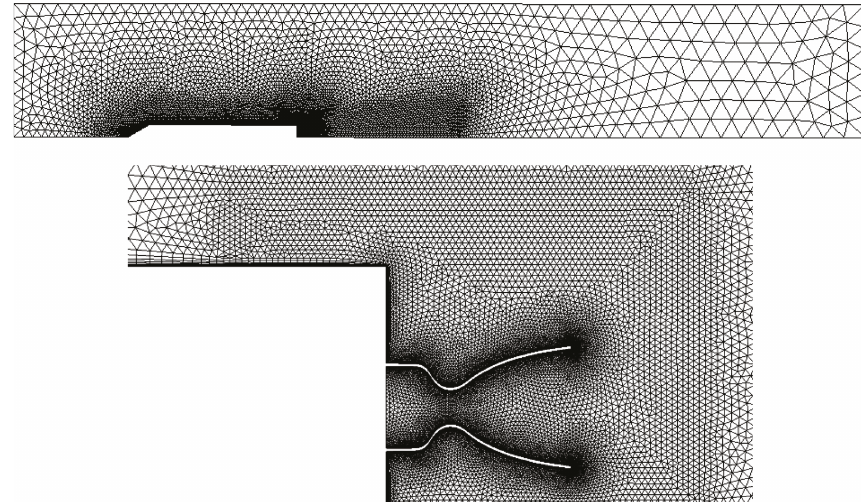
Figure 2: Mesh generated for computation.